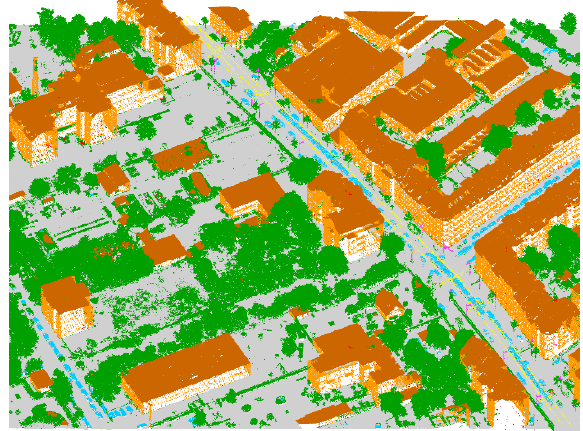
Figure 3 . Classification results from PointNet++ using prior knowledge (height above ground and input